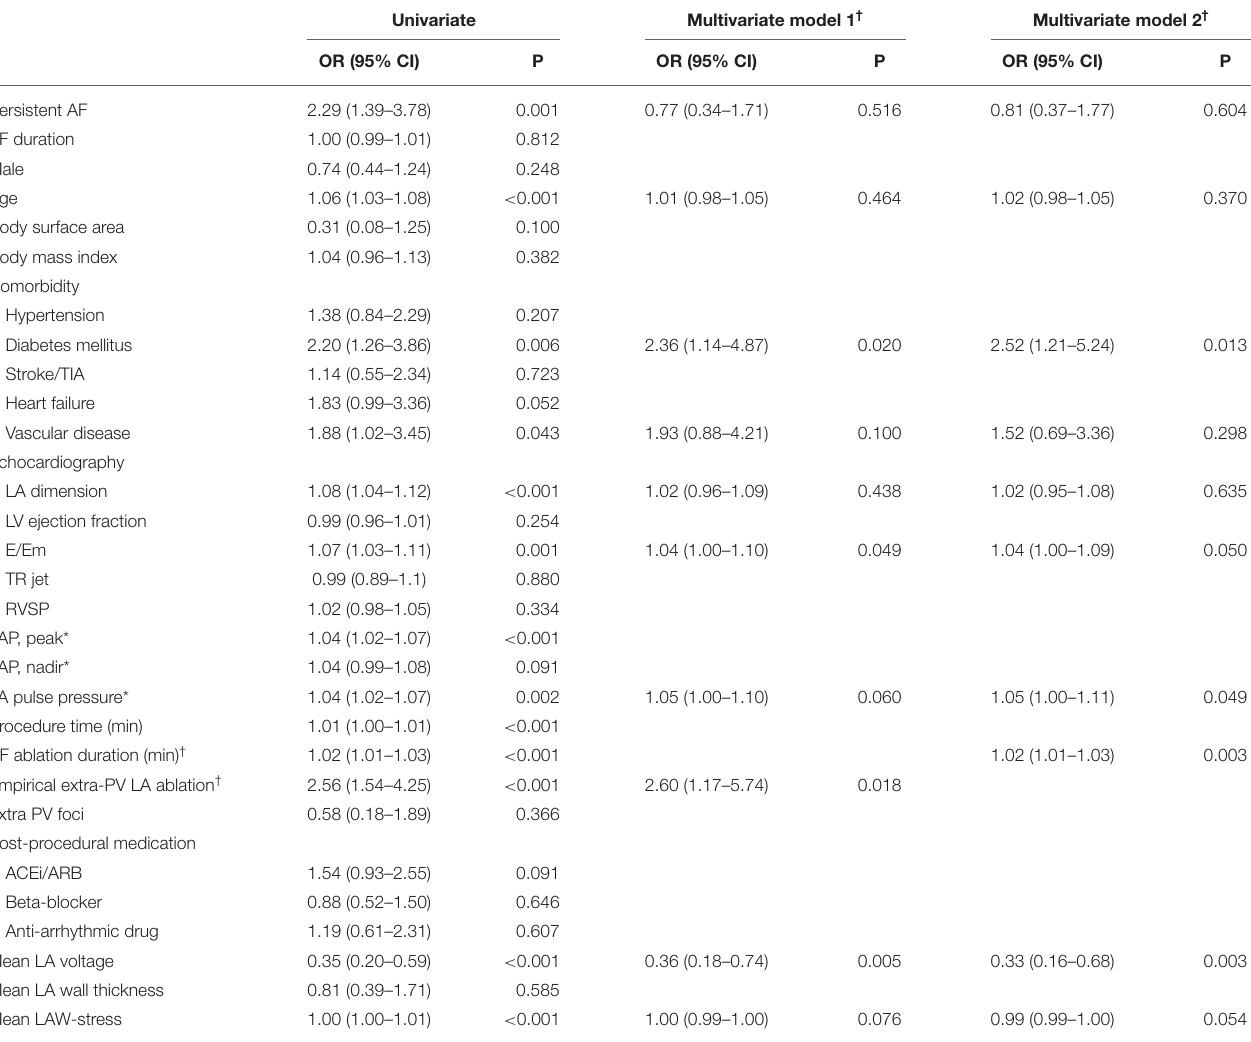
TABLE 3 | Logistic regression analysis for stiff LA